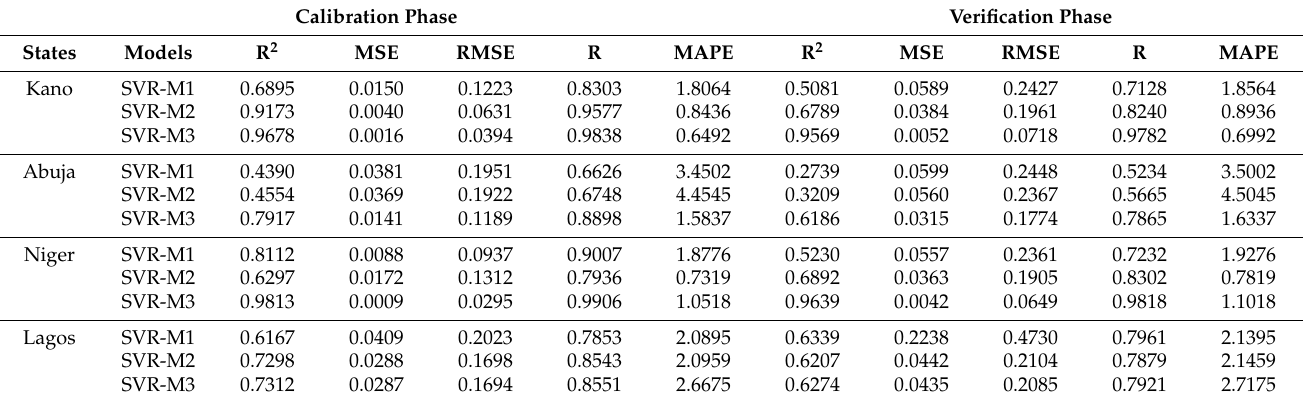
Table 1. Results of evaluation for traditional SVR models (Kano, Abuja, Niger, and Lagos).